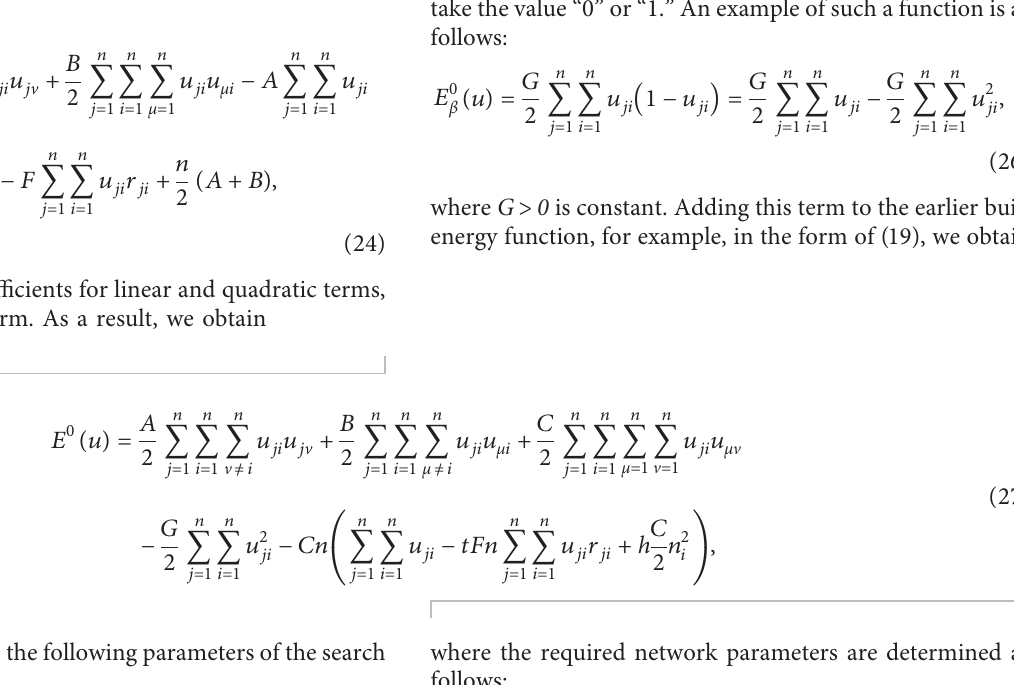
Figure 5: Dynamic neural network relaxing to its energy minimum interpreted as the maximum total value of relevance in the com- binatorial group of